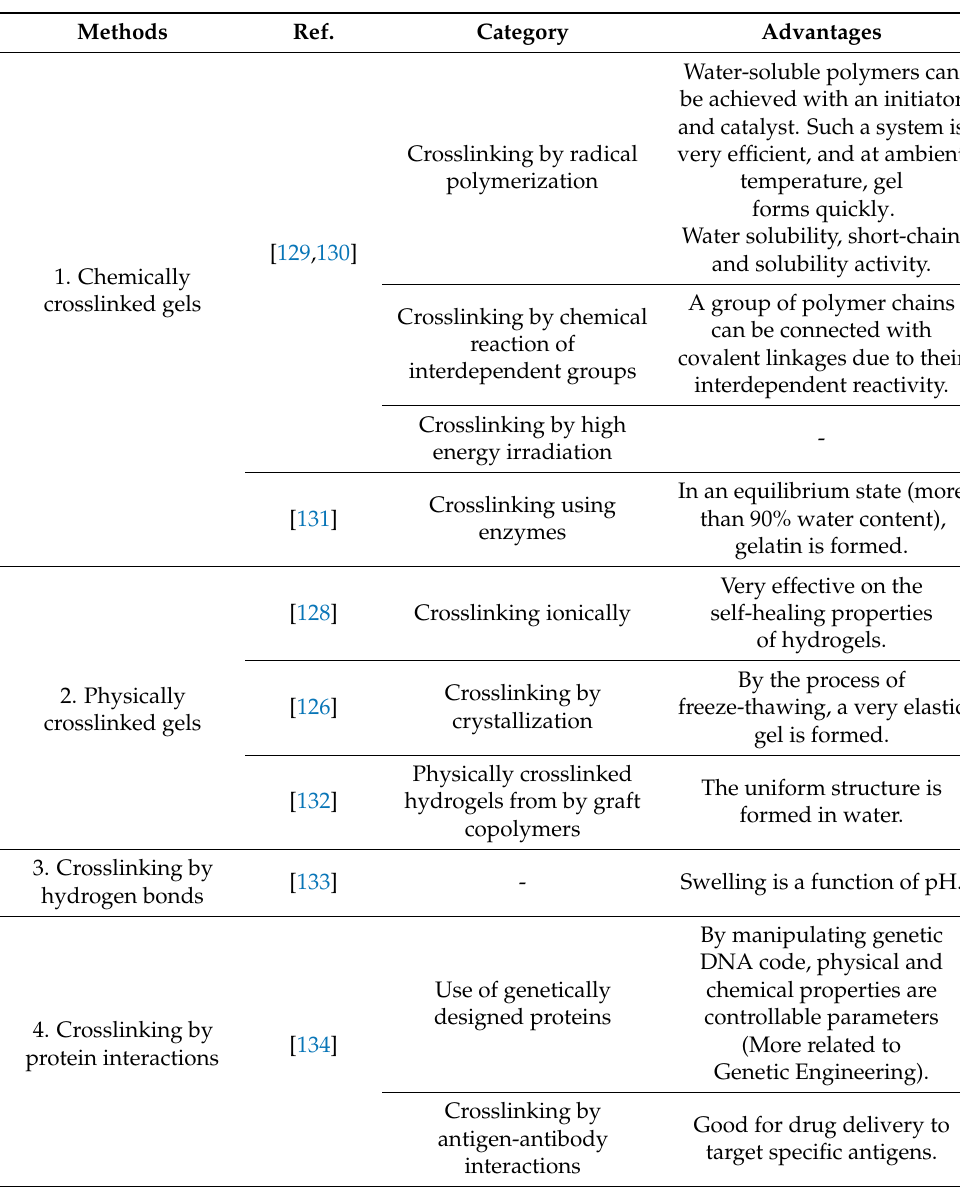
Table 3. Crosslinking methods to design